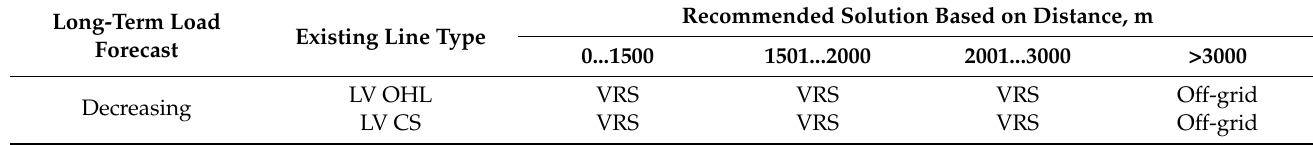
Table 8. Summary of the recommendations to solve voltage